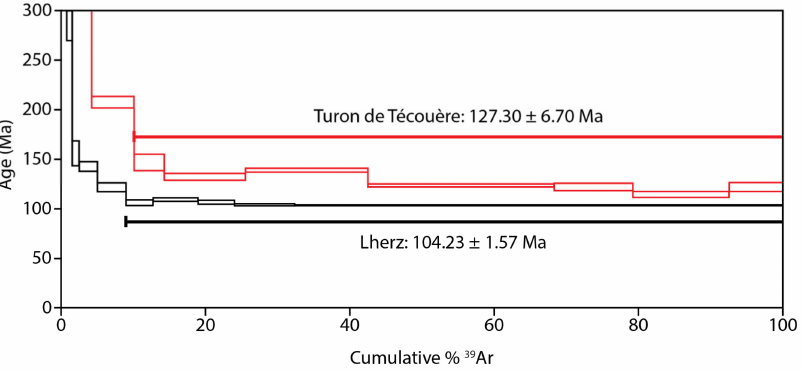
Figure 7. 40 Ar/ 39 Ar ages plotted vs. the amount of 39 Ar for amphibole veins from the Lherz and Turon de T é cou è re peridotite bodies. Results are presented with 2 σ analytical errors. 40 Ar/ 39 Ar data are presented in Tables S1 and